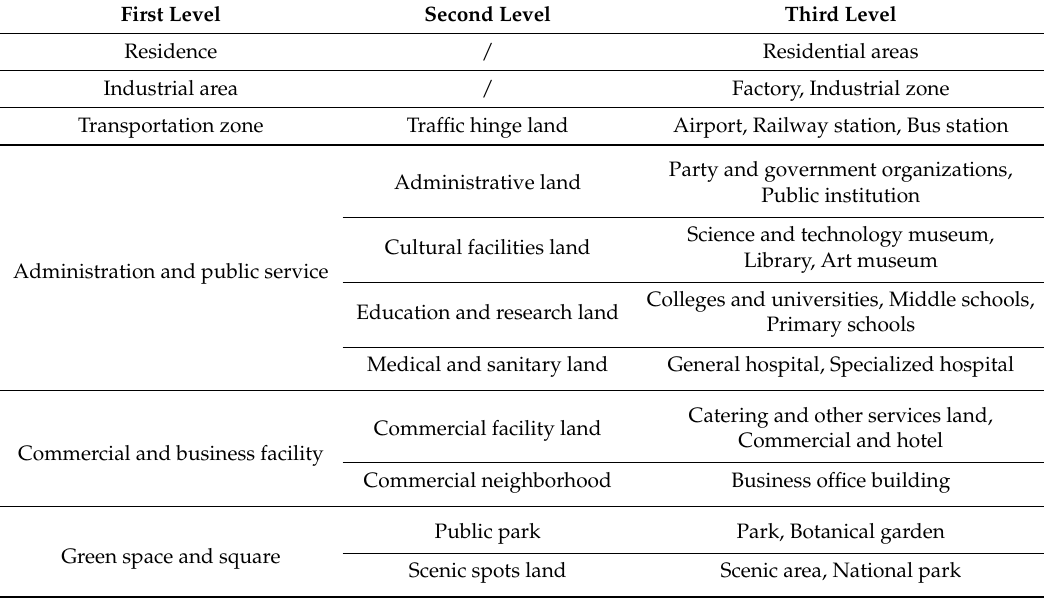
Table 1. The categories of urban functional regions based on the urban land use and planning standards of development land (GB50137-2011)